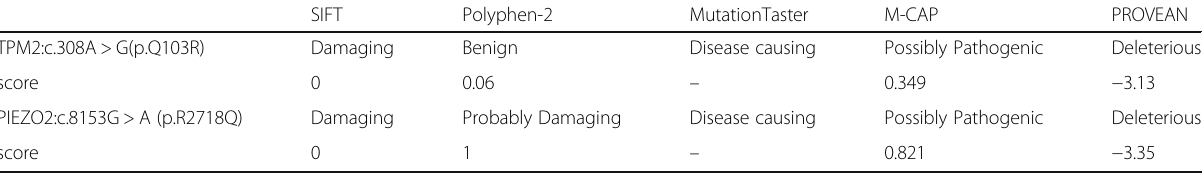
Table 2 Predictions of functional effects for two mutations in this study SIFT Polyphen-2 MutationTaster M-CAP